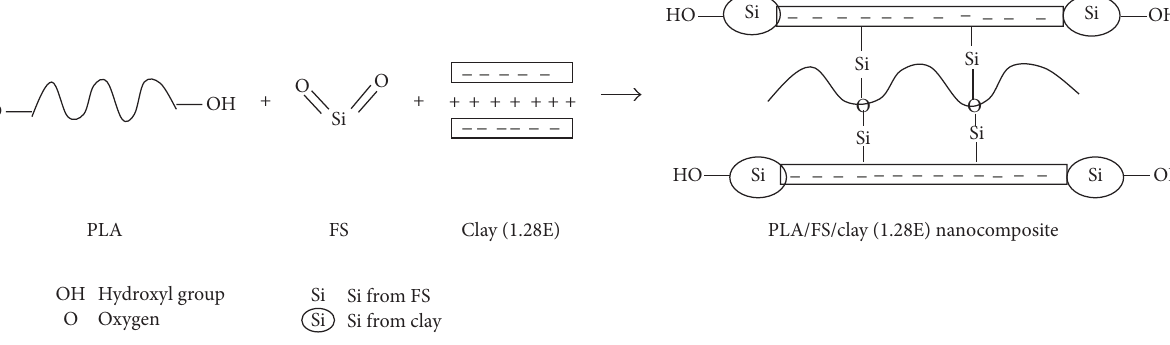
Figure 2: The formation of PLA/FS/clay (1.28E) nanocomposite by ion exchange